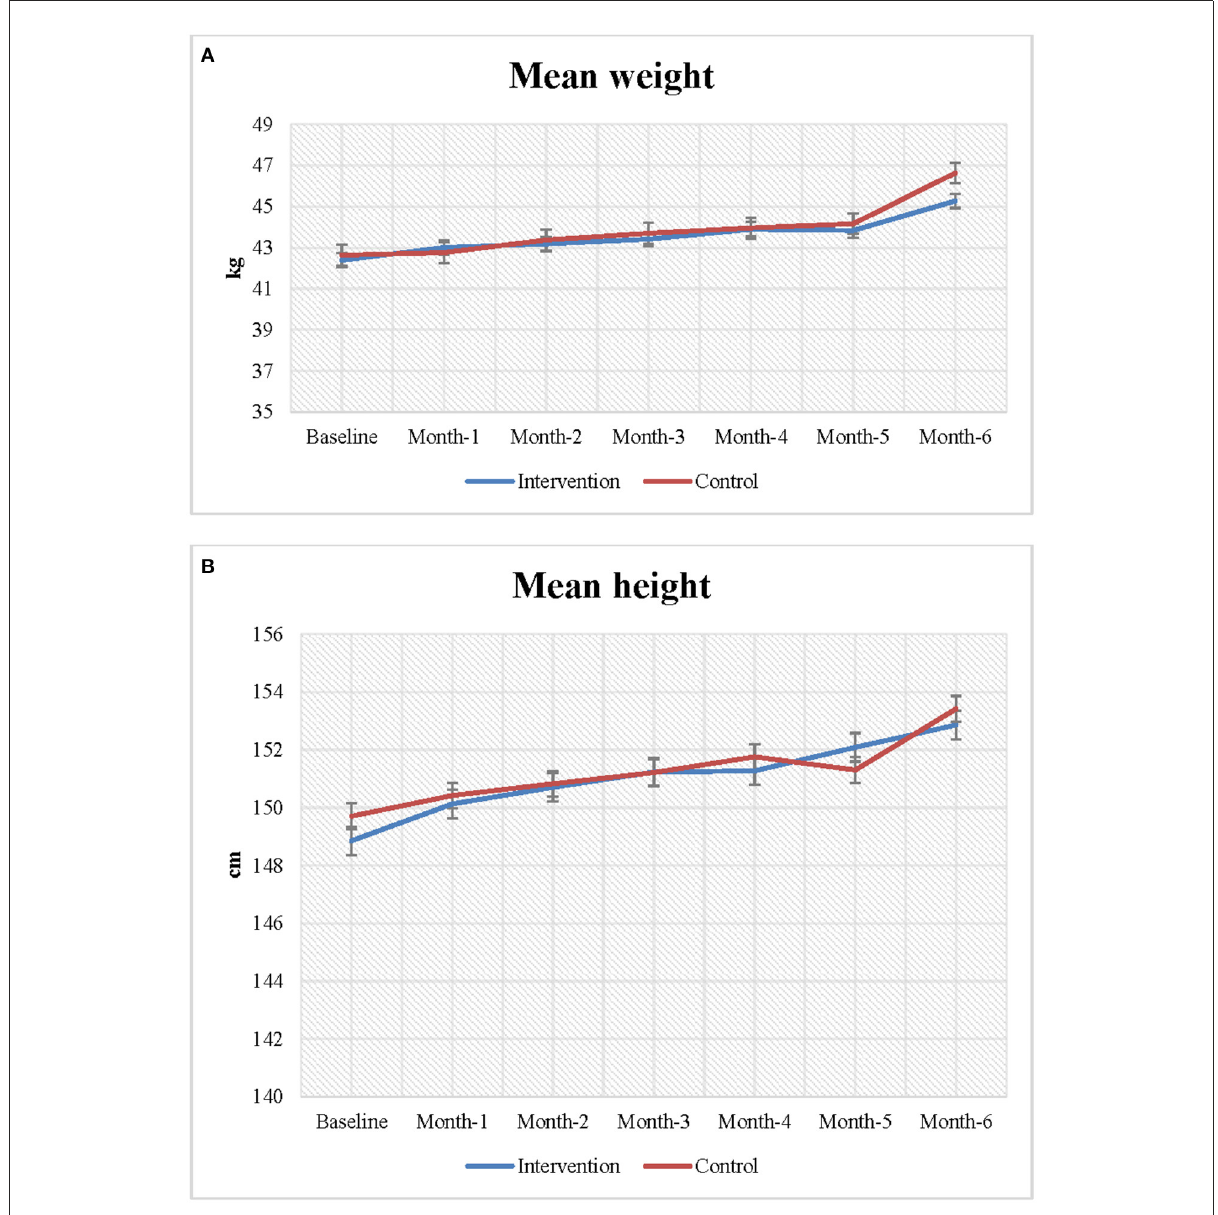
FIGURE2 (A,B) Changes in nutritional status among the study